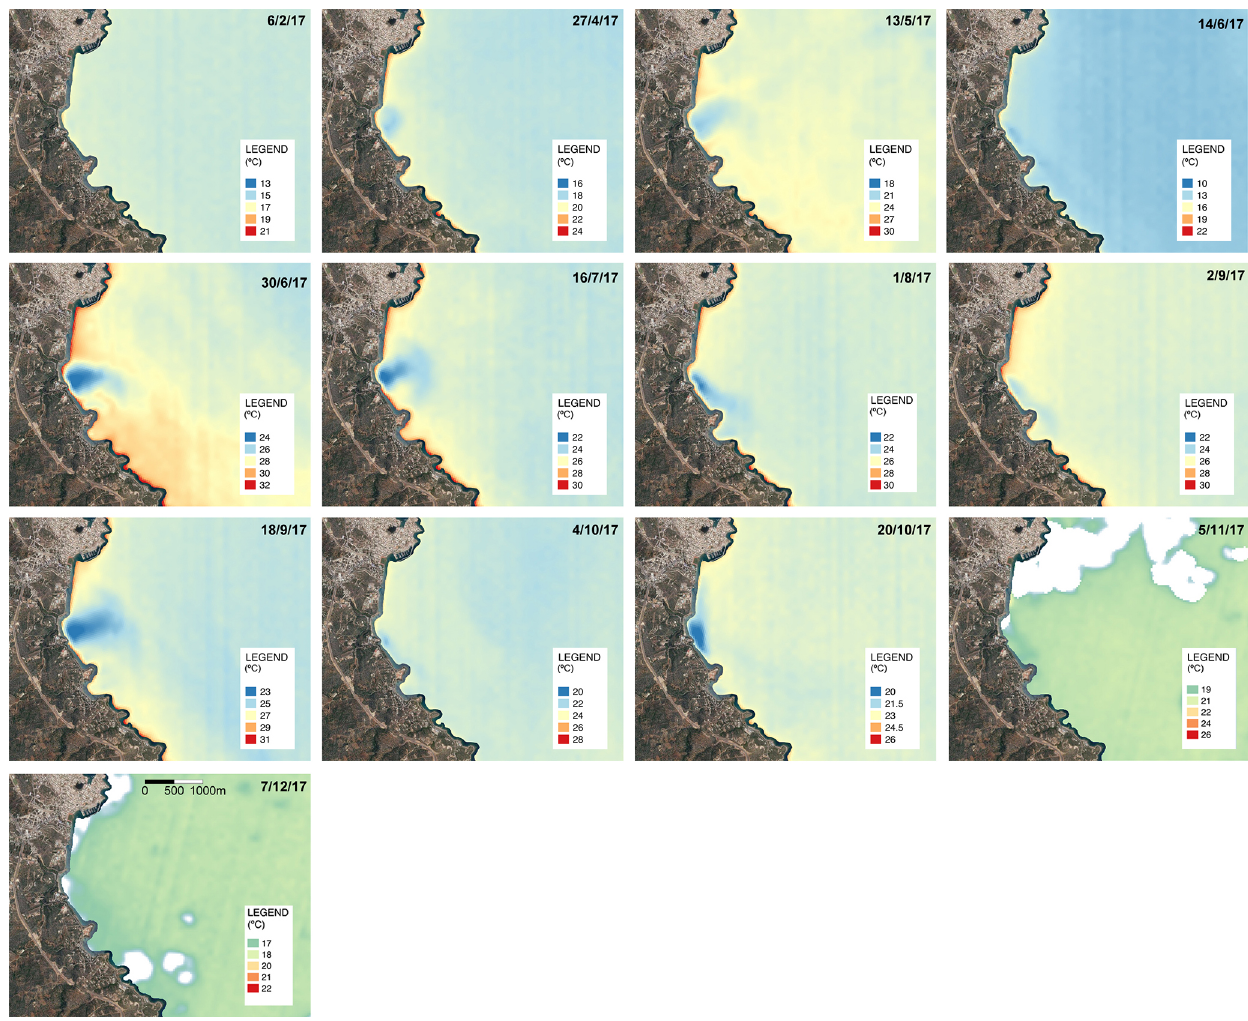
Figure 2. SST images (degrees Celsius) obtained via band 10 of Landsat 8 OLI/TIRS of the region of Almyros of Agios Nikolaos (Crete, Greece) throughout 2017. Of the 23 images analyzed, the presence of an SGD spring was clearly visible in nine images that represent a 37% ratio of success. In January, March and November 2017, it was not possible to obtain an SST image due to the presence of clouds. © Google Earth